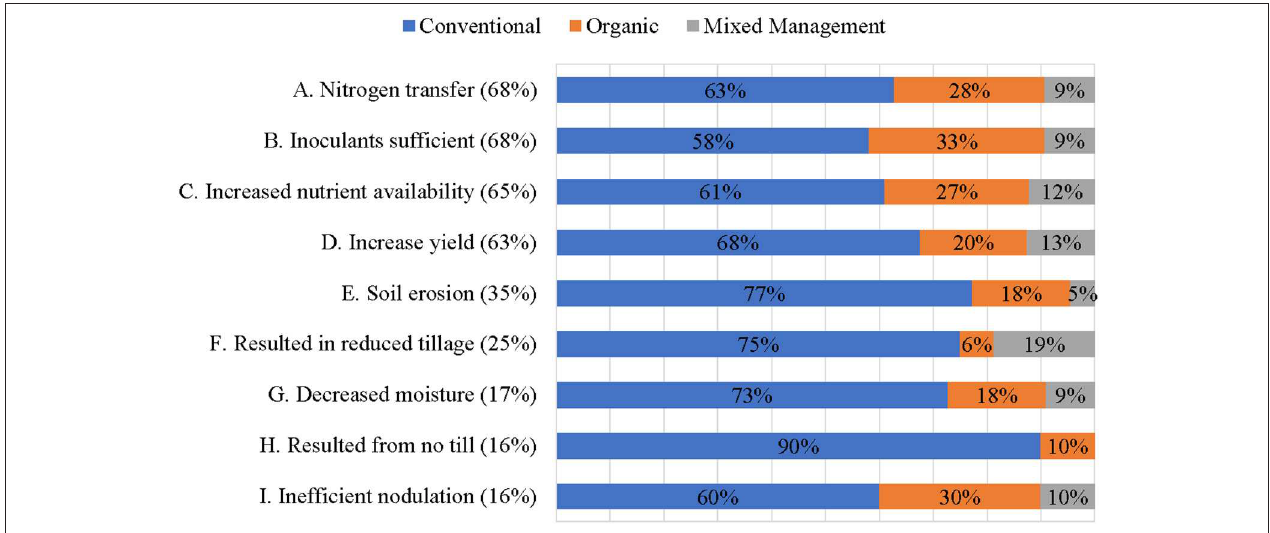
FIGURE 3 | Agronomic effects from lentil. Total percentage (shown in parenthesis) and the proportion of conventional, organic, and mixed management producers that reported agronomic affects that resulted from including lentil in production that include (A) nitrogen transfer to subsequent crop, (B) rhizobium inoculants sufficient, (C) increased nutrient availability for subsequent crops, (D) increased yield in overall food crop production, (E) soil erosion, (F) resulted in reduced tillage, (G) decreased moisture availability, (H) resulted from no-tillage, and (I) inefficient nodulation ( n =